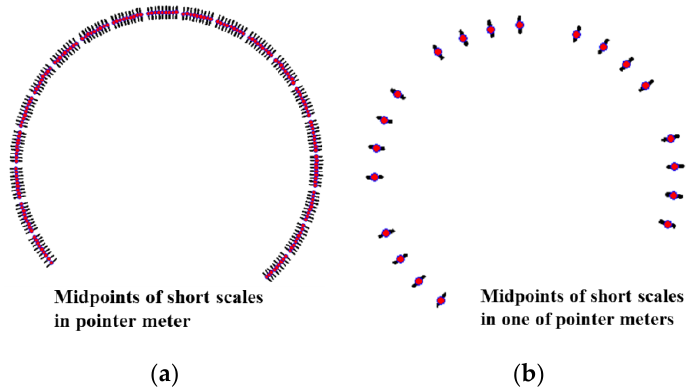
Figure 6. ( a ) result of all the midpoints of short scales in the pointer meter with radius of 620 mm; ( b ) result of all the midpoints of short scales of the meter on the left in the image with radius of 406 mm. Second, normal vector